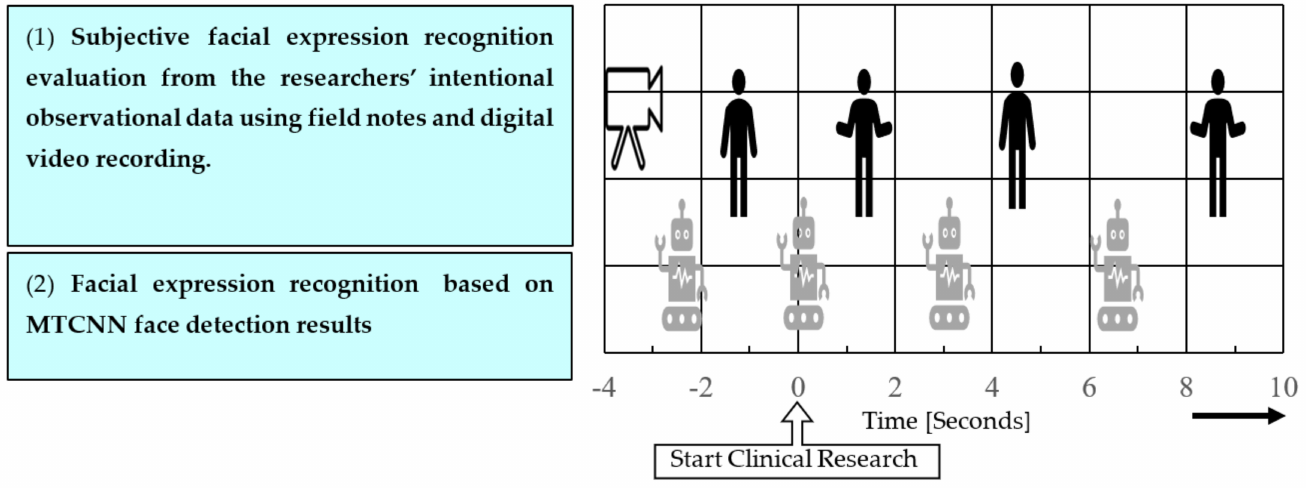
Figure 1. Research framework simultaneous research data collection designed in accordance with the intentional observational clinical research design [16]. Arrow indicates